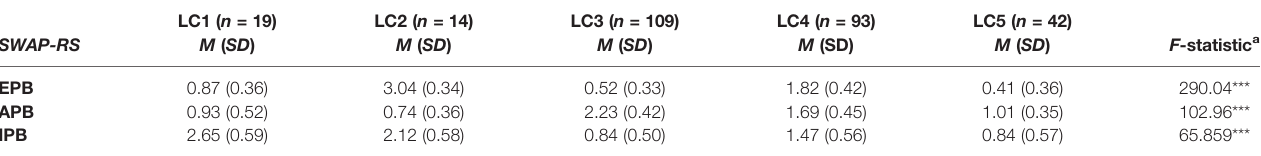
TABLE 2 | Descriptive statistics of the Shedler-Westen Assessment Procedure – Rating Scale (SWAP-RS) factors by latent class.